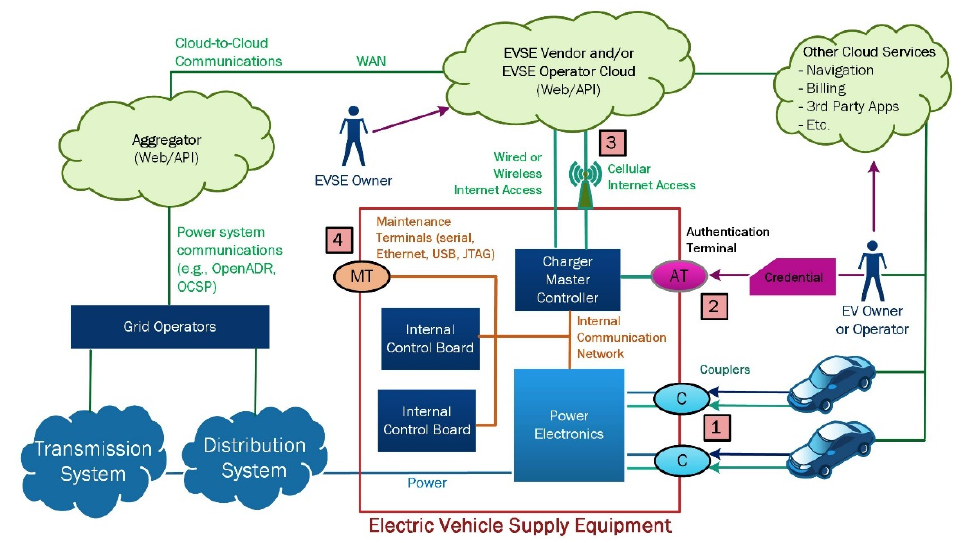
Figure 1. Electric vehicle communication ecosystem with EVSE components and external entities.